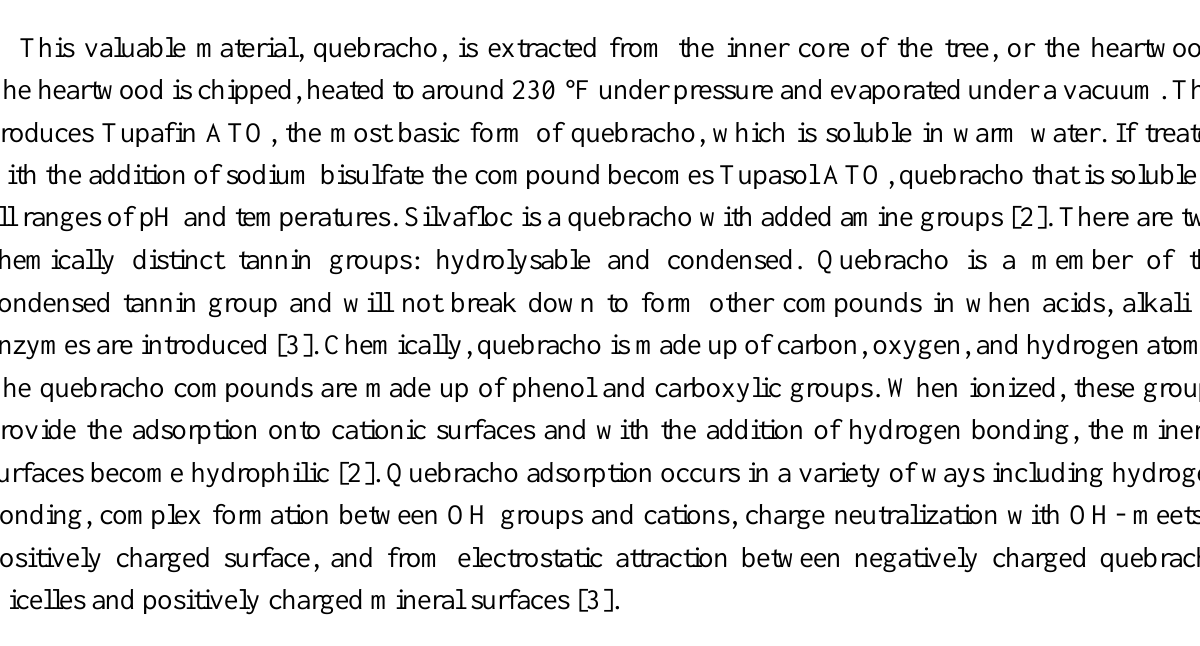
Figure 1. A cut from the Quebracho Colorado tree displays the deep red-brown heartwood